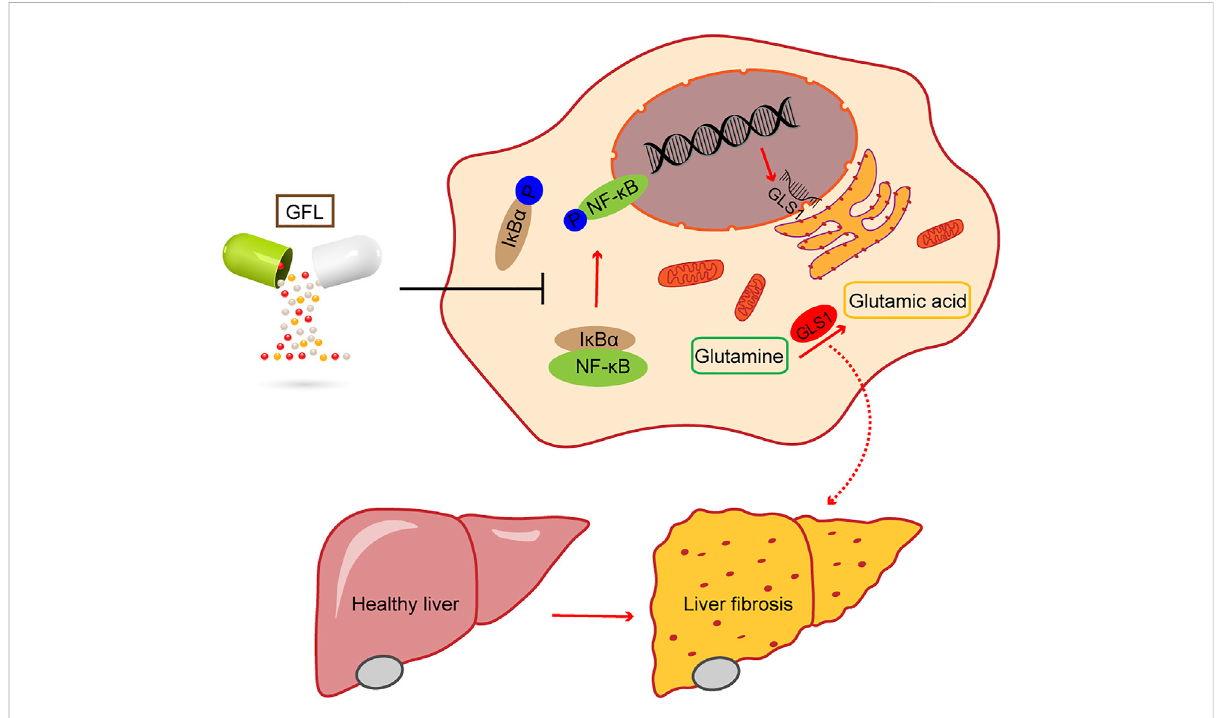
FIGURE 7 Phosphorylation of the NF- κ B pathway regulates GLS1 transcription and translation, while GFL can inhibit the activation of the NF- κ B pathway, reduce GLS1 expression, regulate glutamine metabolism, alleviate liver injury, and relieve liver fi